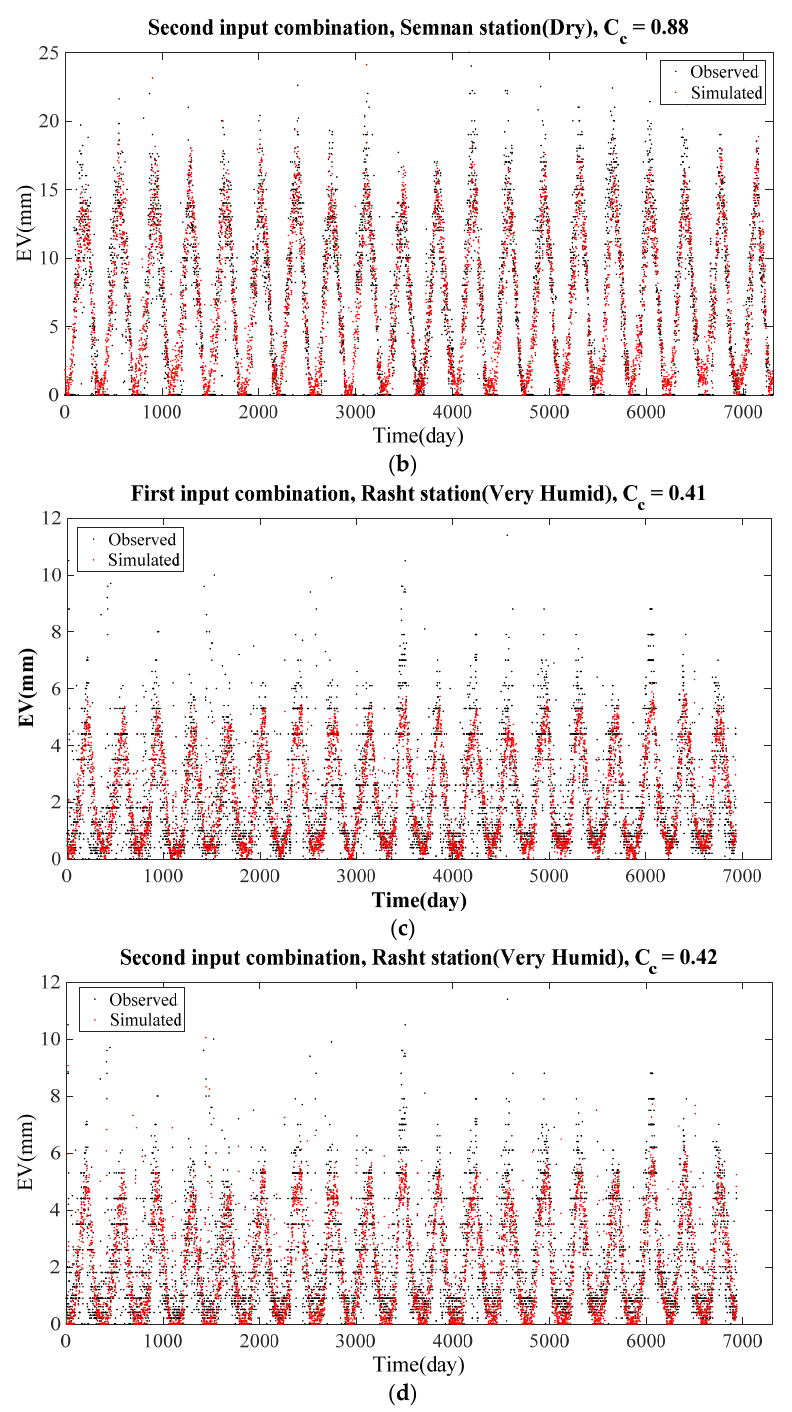
Figure 8. Time series of observed and simulated pan evaporation using the basic relationship with six climatic correction coefficients (2000–2020) for: ( a ) Semnan station (dry, two-parameter input combination), ( b ) Semnan station (dry, four-parameter input combination), ( c ) Rasht station (very humid, two-parameter input combination), and ( d ) Rasht station (very humid, four-parameter input combination).